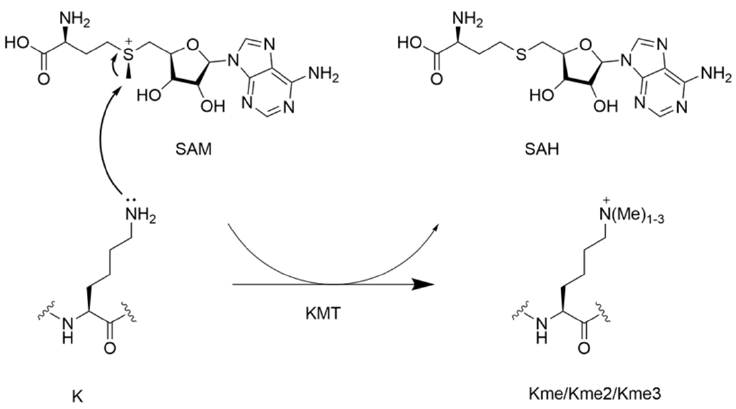
Figure 5. Methyltransferase (KMT)-catalyzed methylation of lysine residues in the presence of the S-adenosylmethionine (SAM) cosubstrate.